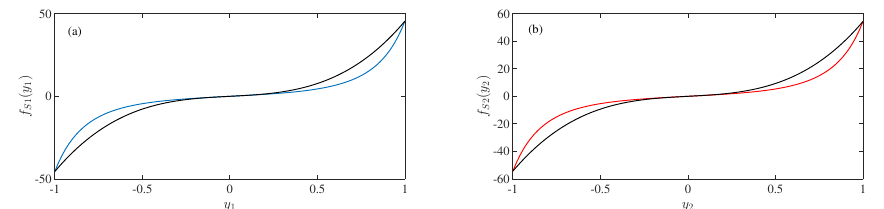
Figure 5. Comparison the magnetic spring force terms f S1 ( y 1 ) and f S2 ( y 2 ) obtained from the different expressions with the variation of the ( a ) state-variable y 1 and ( b ) state-variable y 2 . The x -axes are the non-dimensional displacements (i.e., state-variables y 1 and y 2 ) and the y -axes are the non-dimensional magnetic spring force terms. The parameter values are: D 1 = 1.5, δ 1 = 1, ( a ) b 1 = 45.7143, ( b ) b 2 = 54.5737. (Color